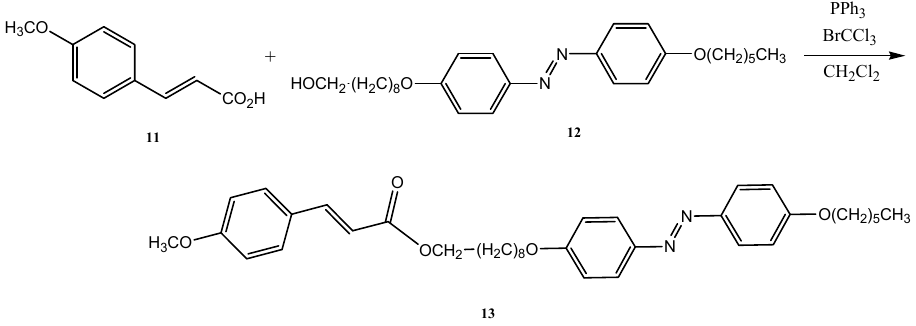
Figure 8. Appel-type reaction using BrCCl 3 -PPh 3 to azo cinnamate 13 .